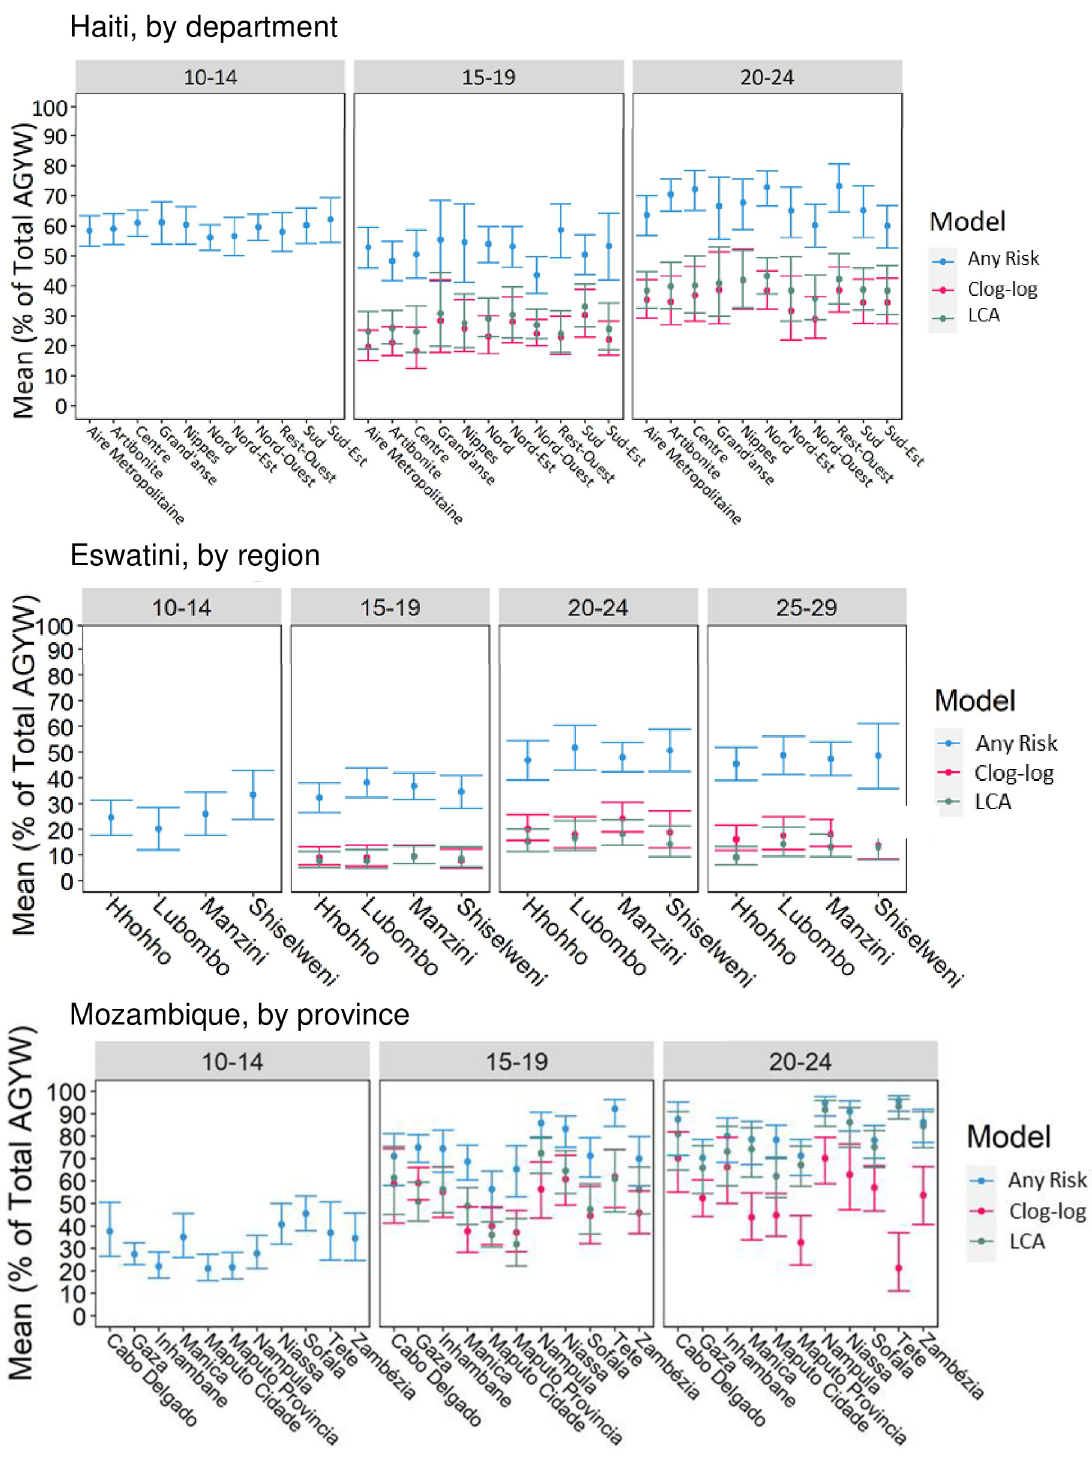
Fig 2. Subnational comparison of risk prevalence estimates, by method (mean with 95% CI). Percentage of AGYW who are HIV- negative and classified as at-risk of HIV infection by country, age band, subnational unit, and model. (A) Haiti–Department level. (B) Mozambique–Provincial level. (C) Eswatini–Regional